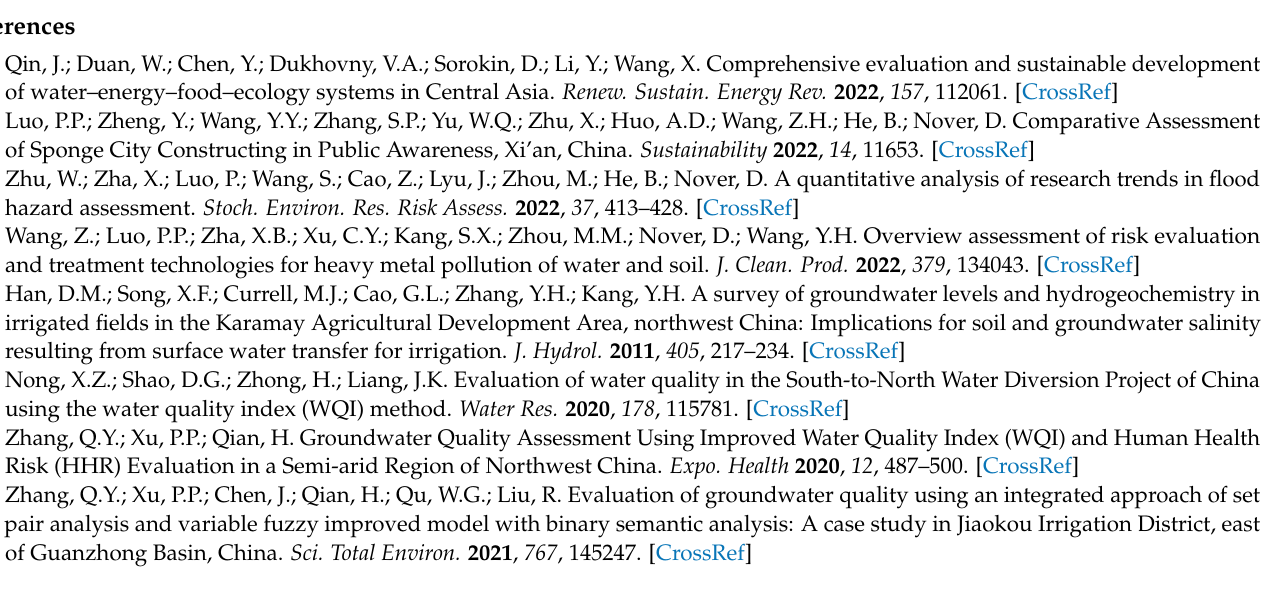
Table S3: Groundwater and surface water allocation for scenario 1; Table S4: Groundwater and surface water allocation for scenario 2; Table S5: Observation well water level changes in 50 years Table S7: Water resources allocation plan after water level restoration for predictive model (scenario 3); Table S8: Observation well water level changes in 50 years for scenario 3; Additional supplementary material: The specific calculation process of the critical